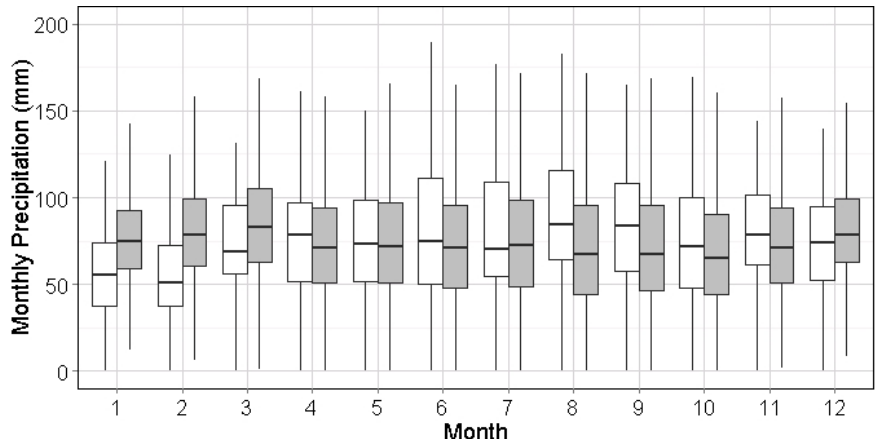
Figure 12. Comparison of monthly precipitation of synthetic series and historical observations in NYC (Historic: White, Synthetic: Grey).